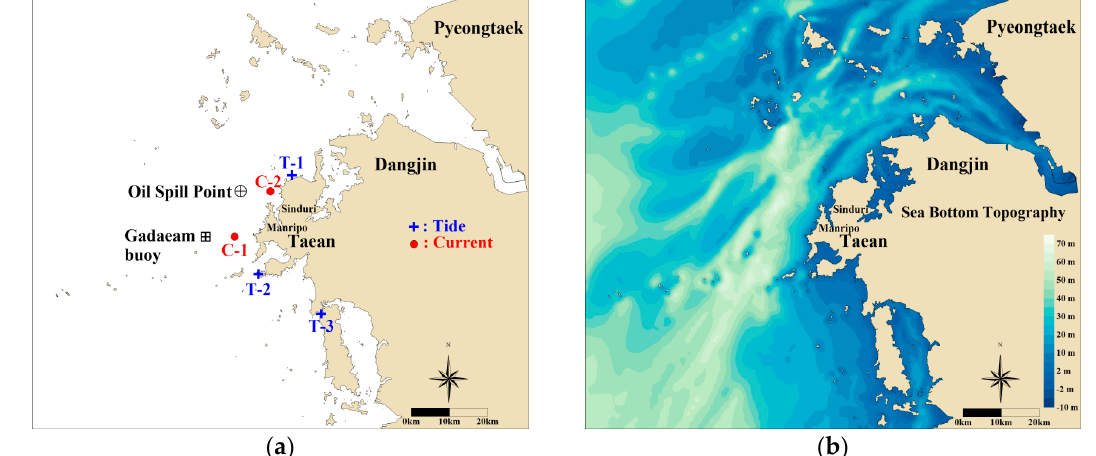
Figure 7. ( a ) Location of verification points ( b ) and bathymetric chart for numerical simulation.